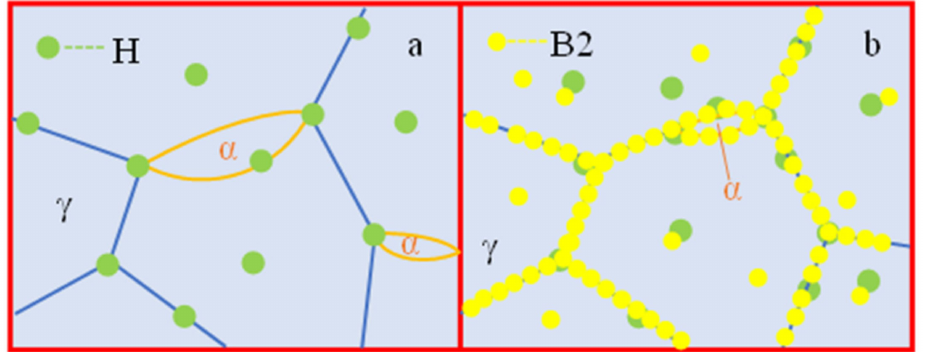
Figure 4. Mechanisms of microstructure change induced by concentration and diffusivity of reversible H ( a ) 0Cu and ( b ) 3Cu, adapted from